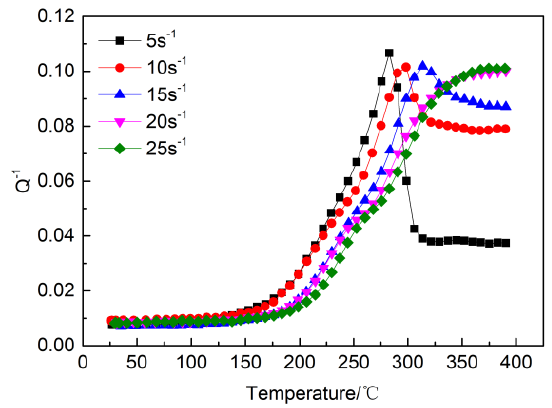
Figure 9. Temperature-dependent damping capacities with f = 1 HZ under di ff erent strain